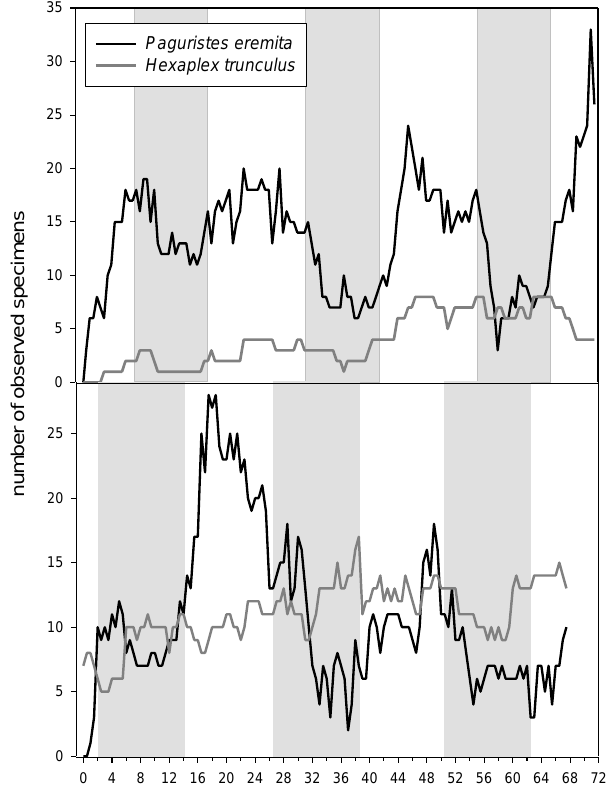
Fig. 3. Day/night activity of Paguristes eremita and Hexaplex trun- Figure 3: Day/night activity of Paguristes eremita and Hexaplex trunculus after anoxia. White bars 850 culus after anoxia. White bars mark daylight hours, grey bars night mark daylight hours, grey bars night. Above: August 2009 plot, below: September 2009 plot. Night 851 hours. Above: August 2009 plot, below: September 2009 plot. Night is about 1 h 30 min longer in September. 852 853 is about 1h 30min longer in September.